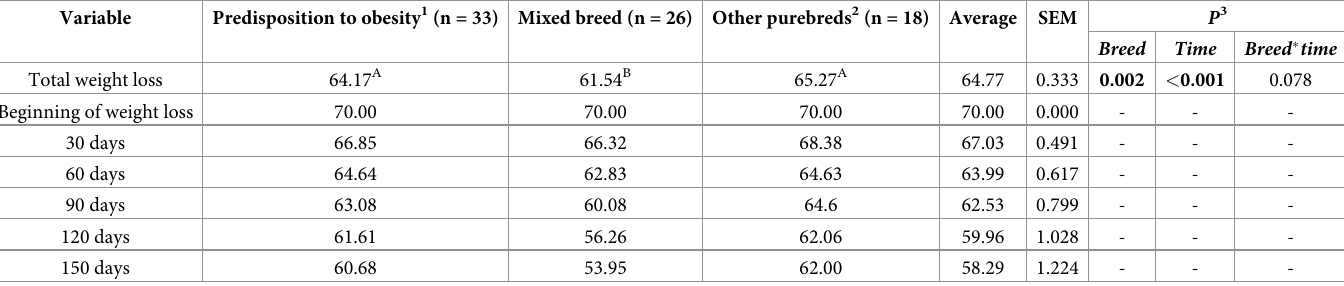
A-B Averages in the same line followed by different letters differed by 5% in the Tukey test adjusted by PROC MIXED. 1 Breeds popularly classified as prone to obesity [Golden Retriever (n = 6), Labrador (n = 17), Beagle (n = 2), English Bulldog (n = 2), Pug (n = 2), Cavalier King (n = 1),